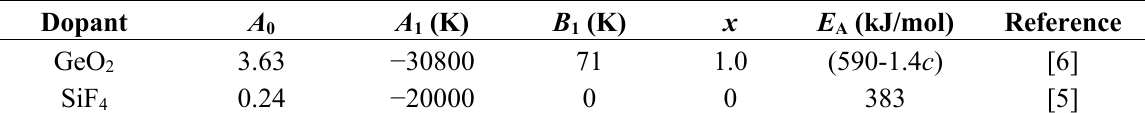
Table 1. Experimentally estimated parameters for temperature and concentration dependent diffusion equation (Equation